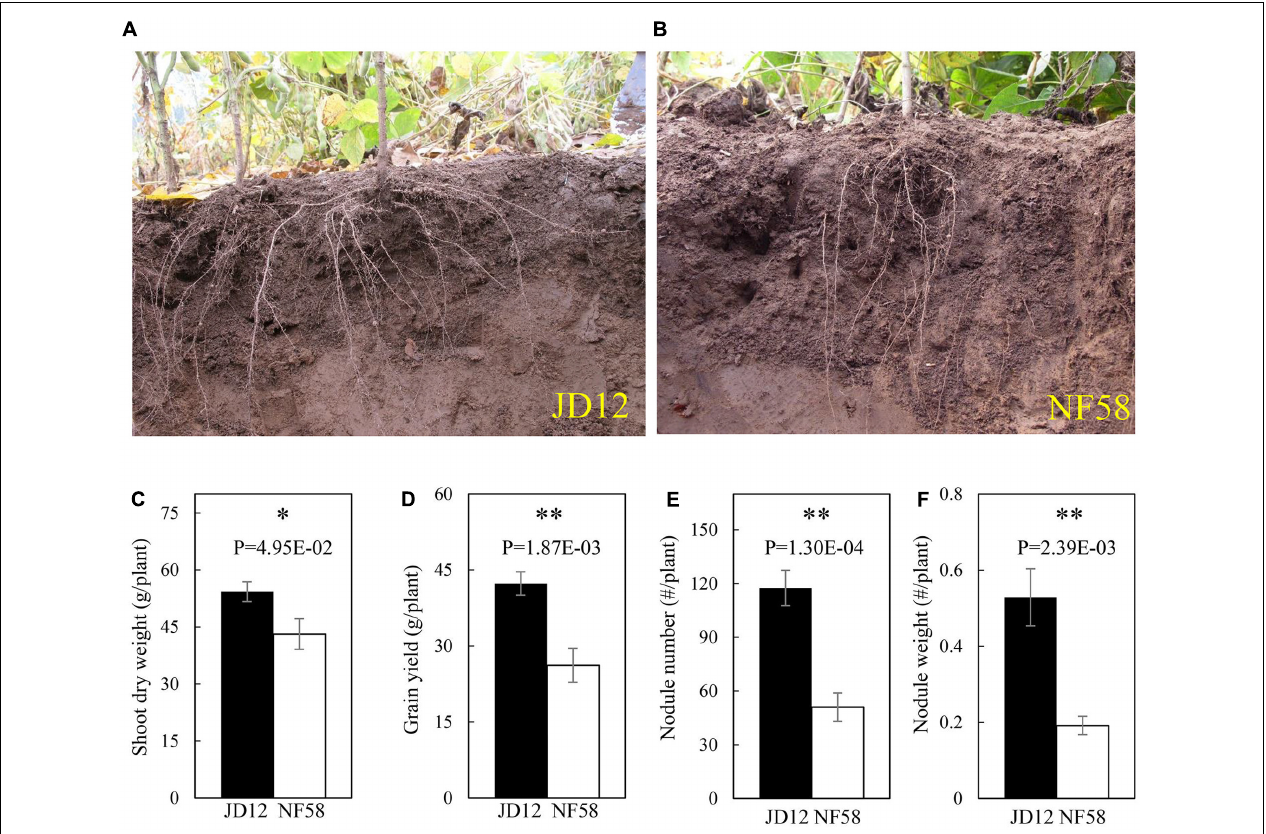
FIGURE 1 | Root architecture, biological nitrogen fixation (BNF) and growth of JD12 and NF58 in the field. (A) Photo of JD12 roots [shallow root architecture); (B) photo of NF58 roots (deep root architecture (RA)]; (C) shoot dry weight (SDW); (D) grain yield; (E) nodule number; (F) nodule weight. Bars represent means ± SE from nine replications. Asterisks indicate the significance of differences between JD12 and NF58 through Student t -test at 5% ( ∗ ) and 1% ( ∗∗ ) level.